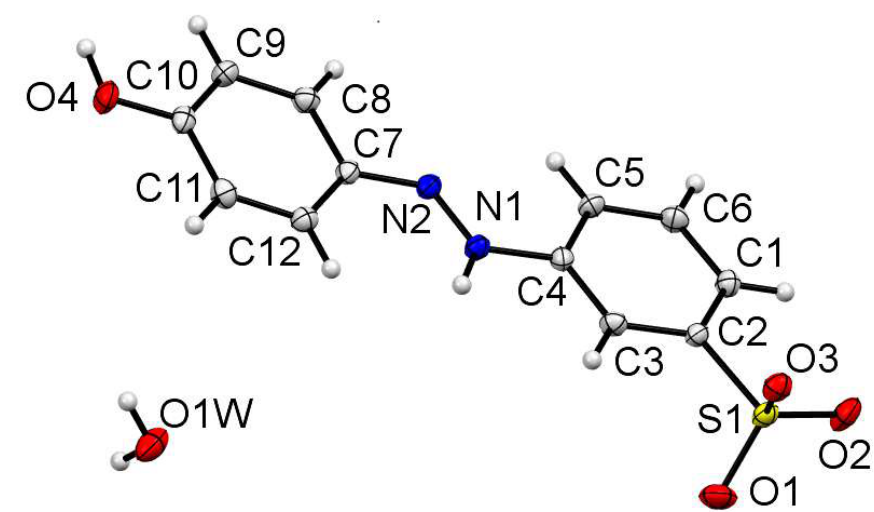
Figure 2. Contents of the asymmetric unit of free acid species H2 .H 2 O. Similar zwitterionic forms with protonation at N1 are the commonest free acid types observed herein. Here and below, displacement ellipsoids are drawn at the 50% probability level and H atoms are shown as small spheres of arbitrary size. This atom-numbering ee is used throughout the comparative discussion of azo geometries below.